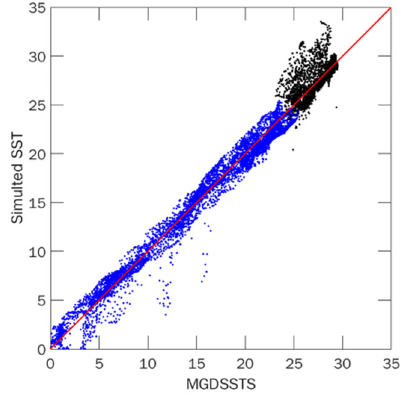
Figure 2. Simulated summer sea surface temperature of ( a ) Exp.C and ( b ) MGDSSTs; simulated winter sea surface tem- perature of ( c ) Exp.C and ( d ) MGDSSTs (unit: °C).